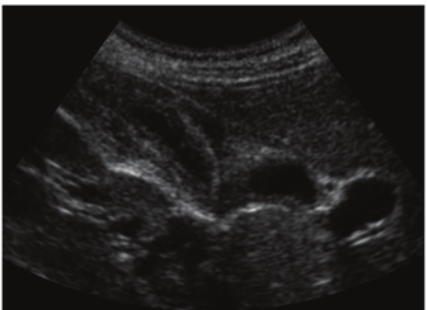
Figure 1: Ultrasound image. Thickening of the gallbladder wall. Minimal pericholecystic liquid is observed.